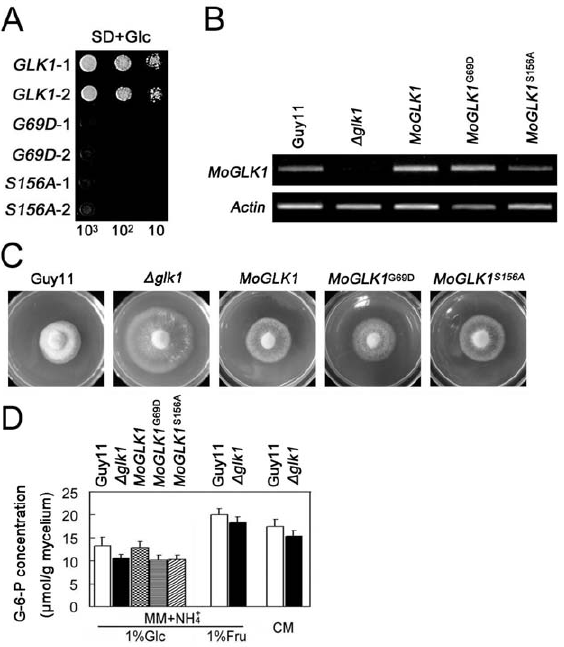
Figure 4. Catalytically inactive Moglk1 alleles restore ammoni- um utilization in the D Moglk1 mutant. (A) Complementation of yeast D hxk1 , D hxk2 , and D Moglk1 triple mutant. Yeast cells transformed with MoGLK1 , MoGLK1 G69D and MoGLK1 S156A were cultured in